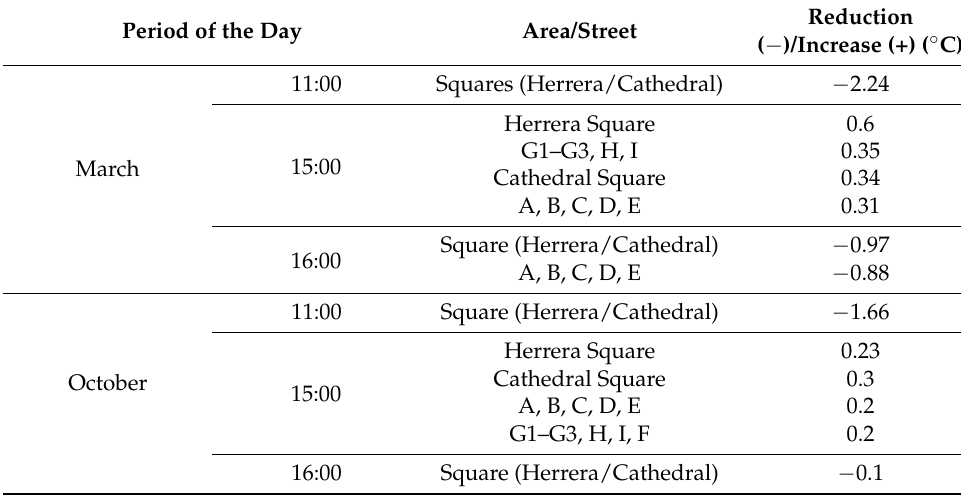
Table 5. Comparison of the mean radiant temperature for base case and case two by streets for critical